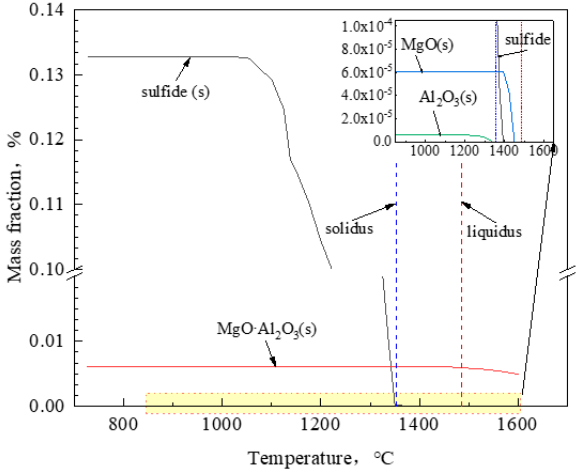
Figure 9. Inclusion content during solidification of sample S2.